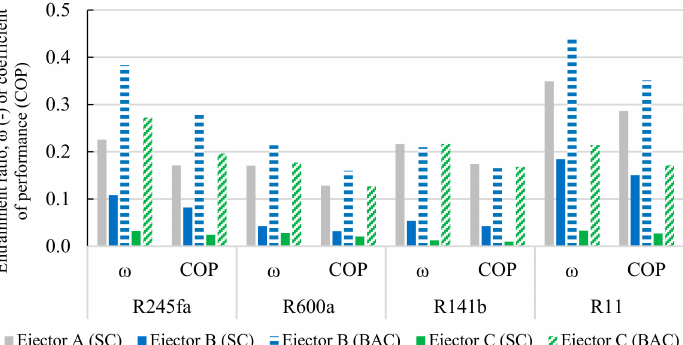
Figure 7. Entrainment ratio and overall refrigeration sub-system COP for each ejector sub-cycle in Figure 1b. SC = simple ejector cycle. BAC = booster-assisted ejector